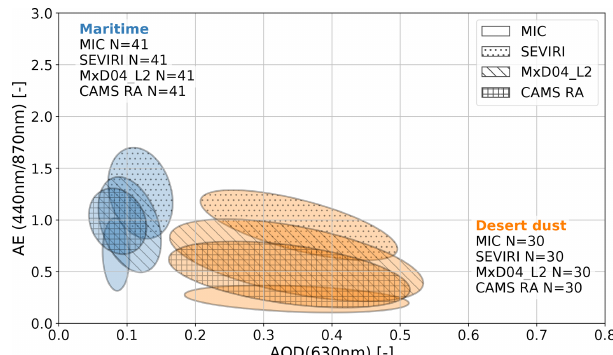
Figure 11. Same as Fig. 7 but comparing CAMS RA AOD instead of MxD04_3K